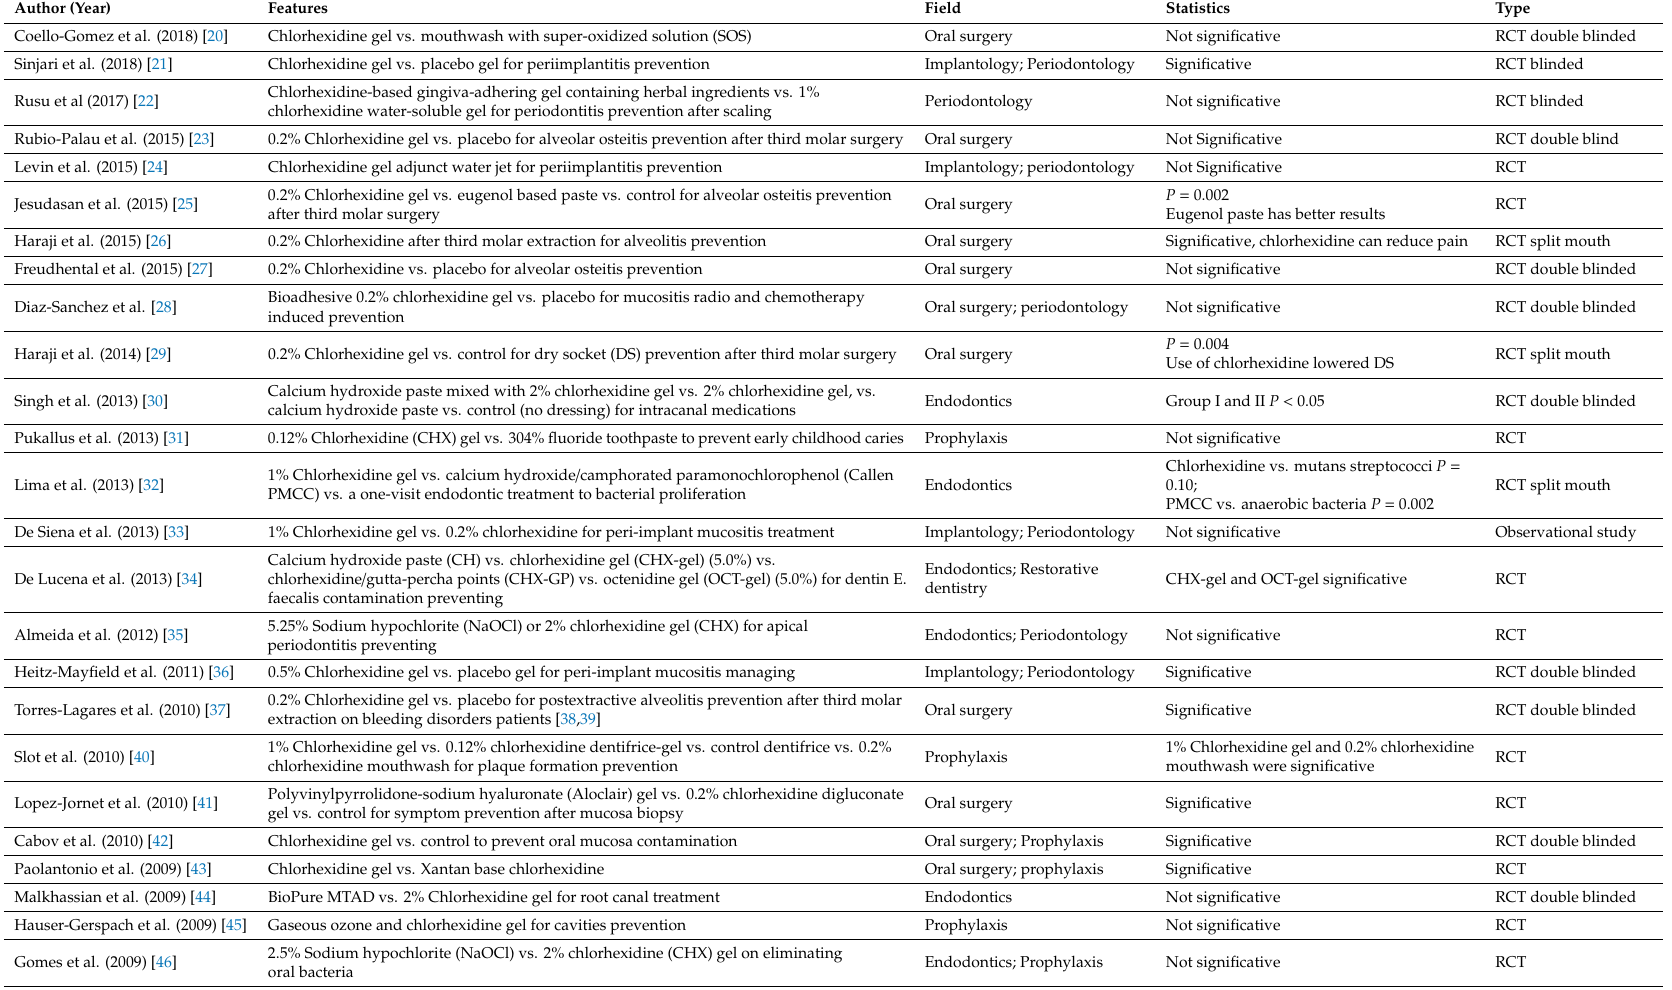
Table 1. Results of the